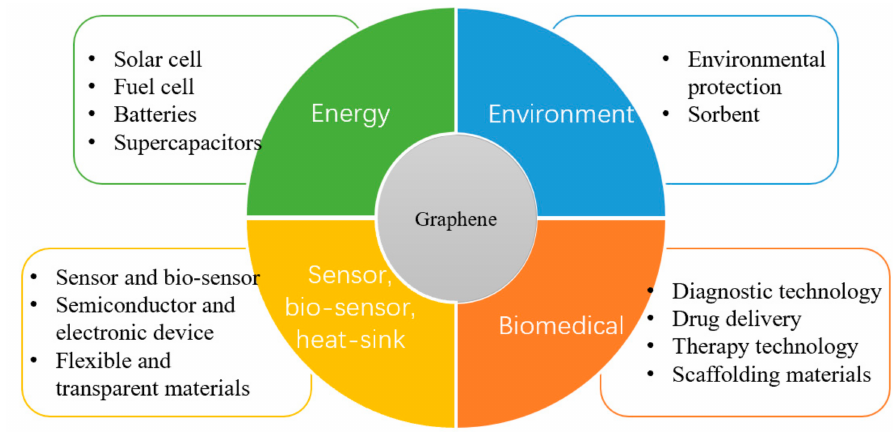
Figure 2. Graphene application in